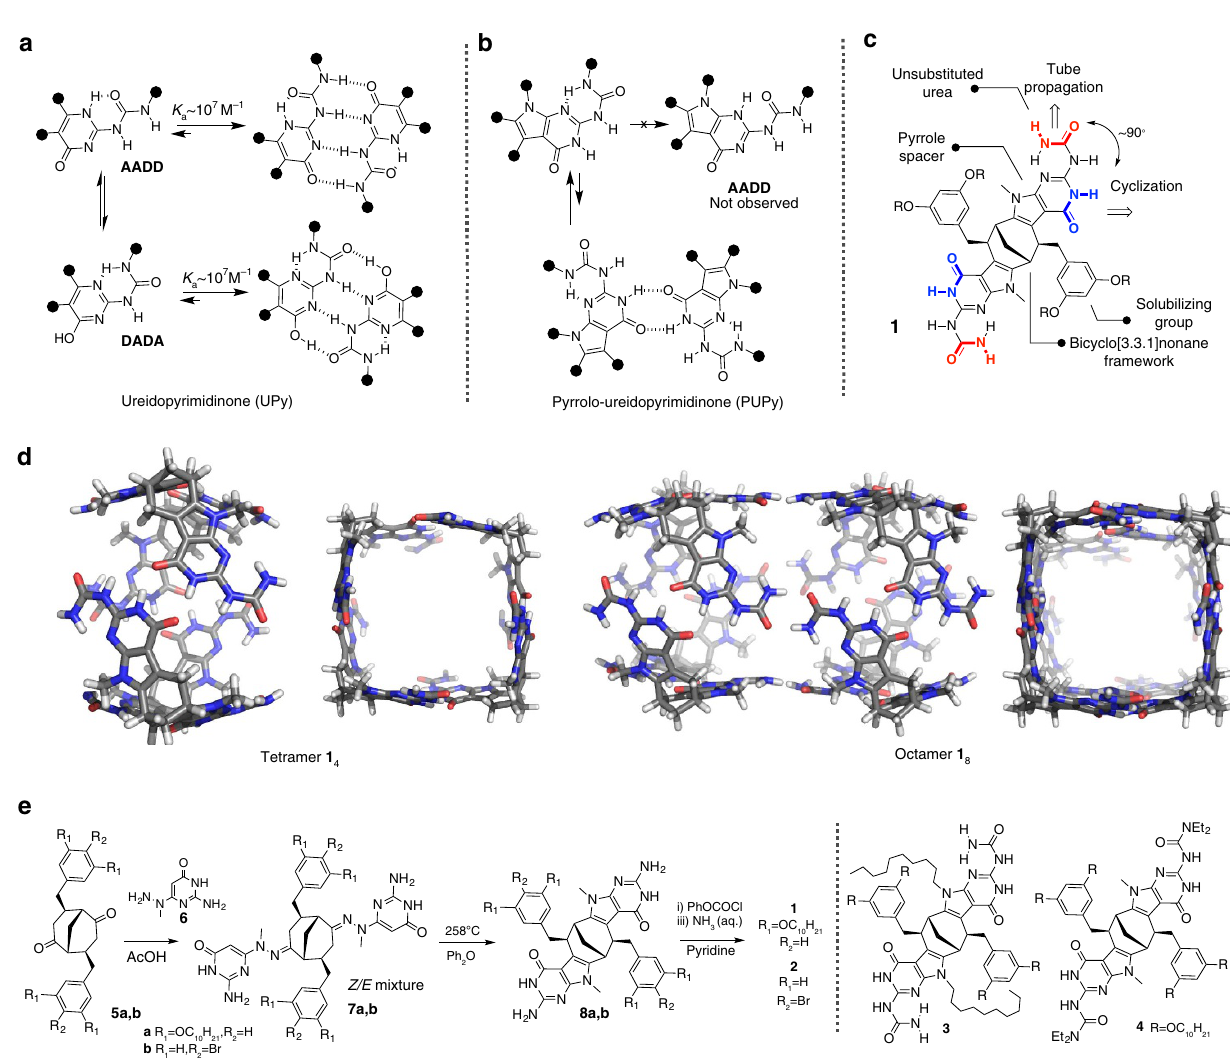
Figure 1 | Monomer design and synthesis. ( a ) Two self-complementary AADD and DADA UPy tautomers and their exceptionally strong dimerization. ( b ) The most stable tautomer of PUPy derivatives and their weak dimerization via 2H-bonding. ( c ) Schematic representation of the essential design elements of supramolecular monomer 1 , allowing two orthogonal 2H-bonding directions (marked as red and blue). ( d ) Molecular models of 2H-bonded tetramer 1 4 and the corresponding tubular polymer assembly, depicted as octamer 1 8 . The solubilizing chains were omitted for clarity. ( e ) Synthesis of monomers 1 and 2 having different solubilizing groups and control compounds 3 and 4